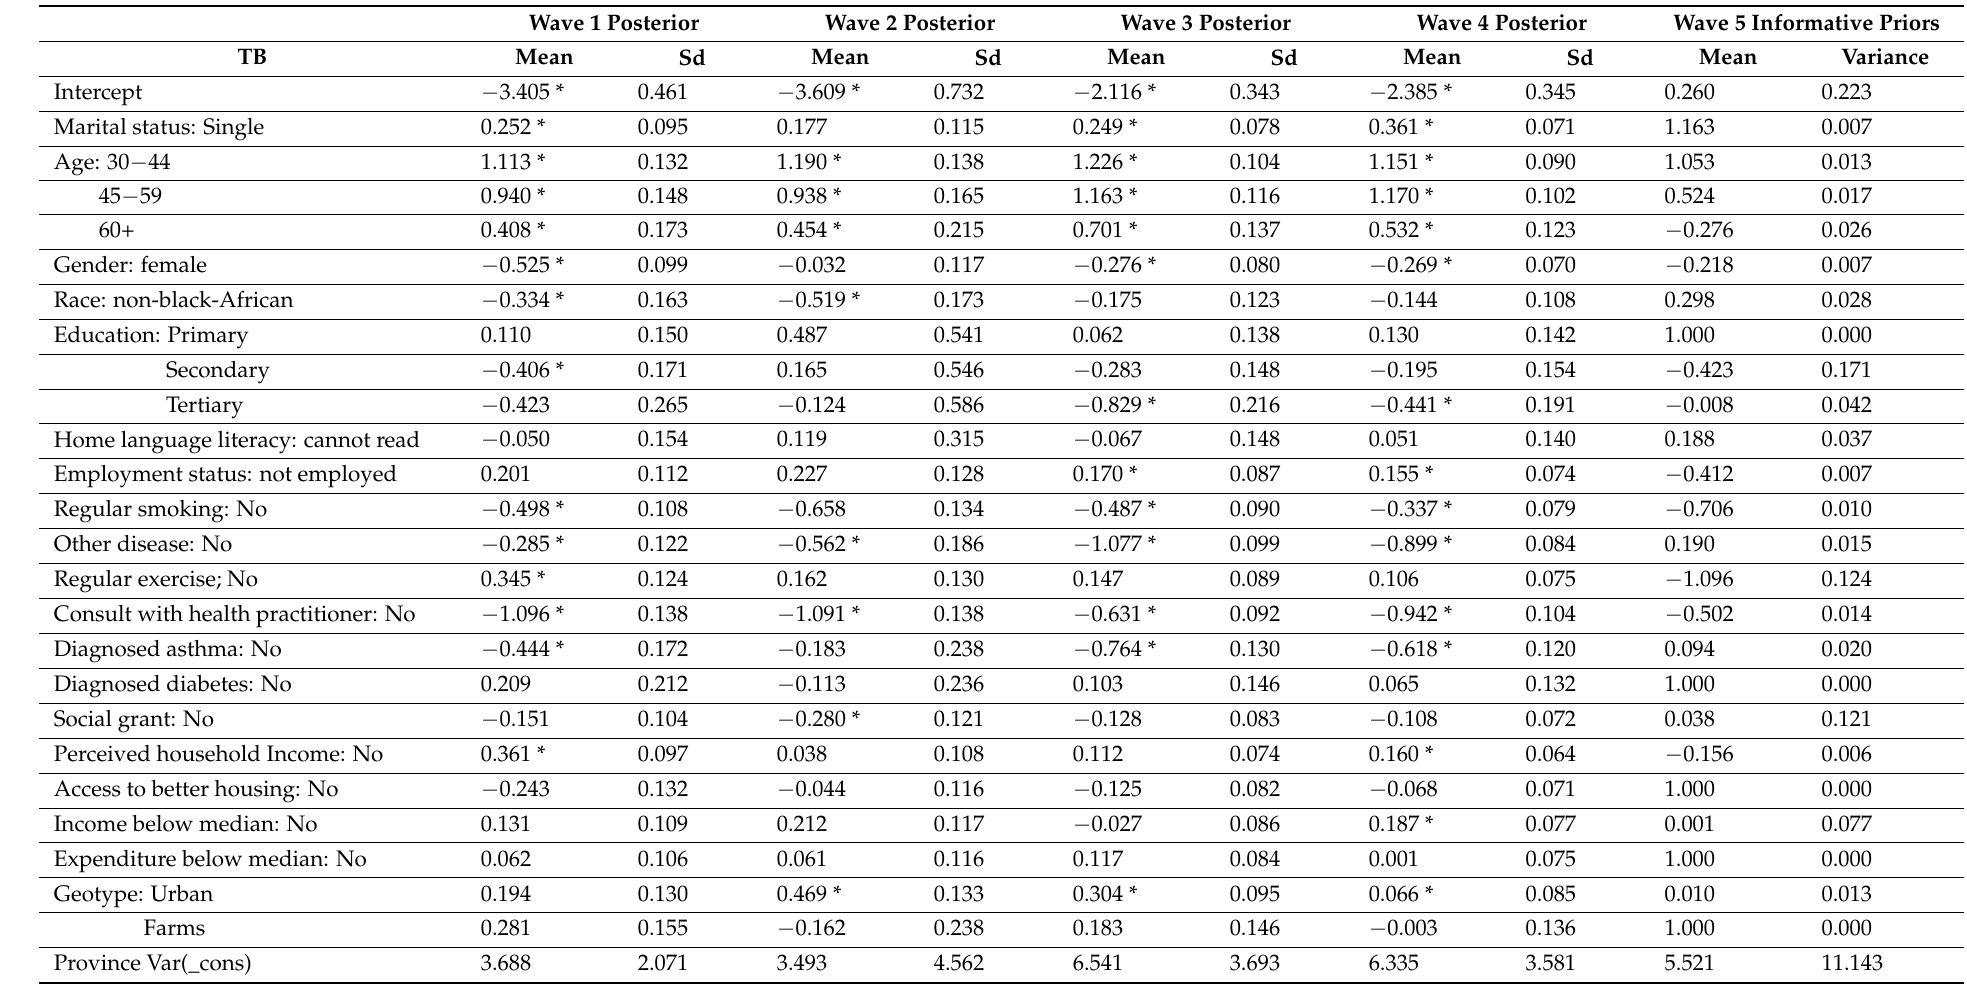
Table A3. Informative